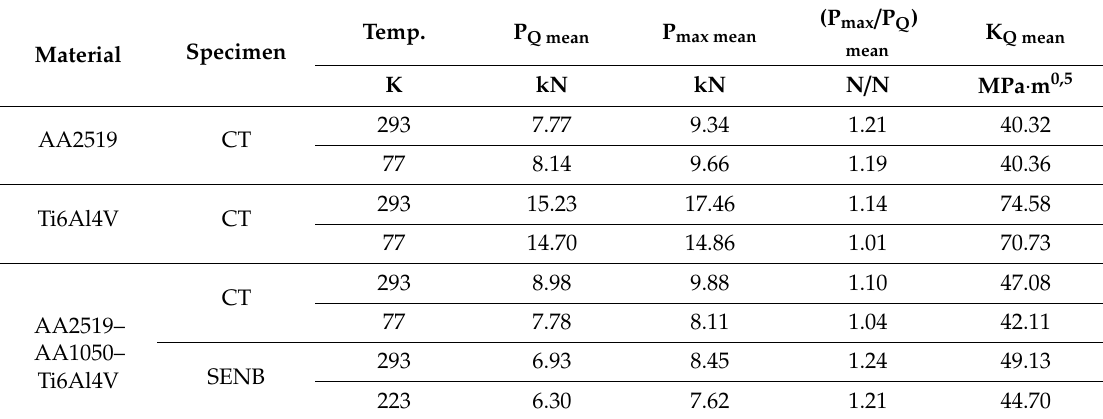
Figure 4. Diagrams of SENB specimen loading at ambient (293 K) and lowered (223 K) temperatures. The values of P Q , P max , P max / P Q , and K Q , determined from the tests are presented in Table 6. Table 6. Fracture toughness test results in the linear-elastic range.